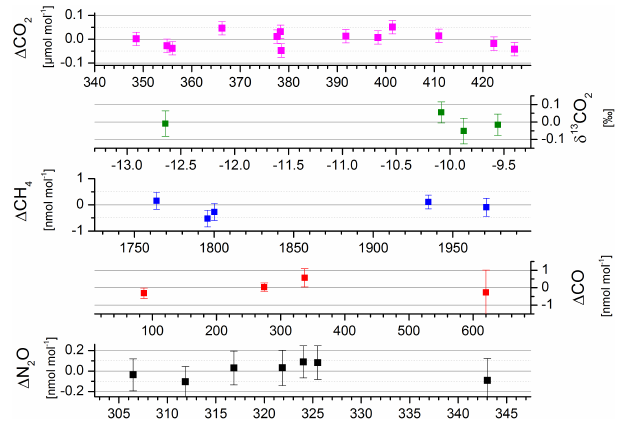
Fig. 5. Residuals with 1 σ error bars from linear regressions of raw FTIR measured mole fractions against reference mole fractions for a suite of tanks maintained by the University of Heidelberg (data and further details from Hammer et al.,